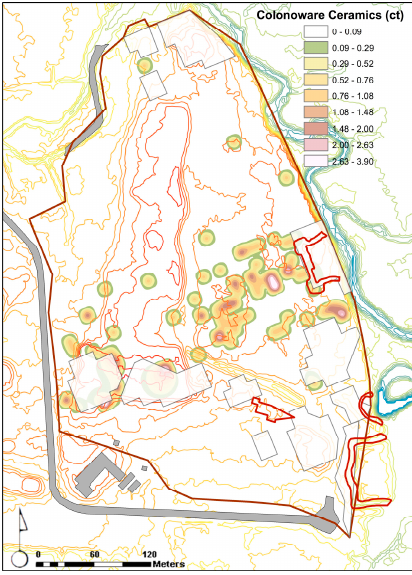
Figure 24. The distribution of Colonoware ceramics recorded through a shovel test survey. Areas whited-out were not shovel tested. Contour spacing is 1 m. Contours are based on the LiDAR dataset and use the NAD 1983 and NAV 1988 horizontal and vertical datum, respectively.